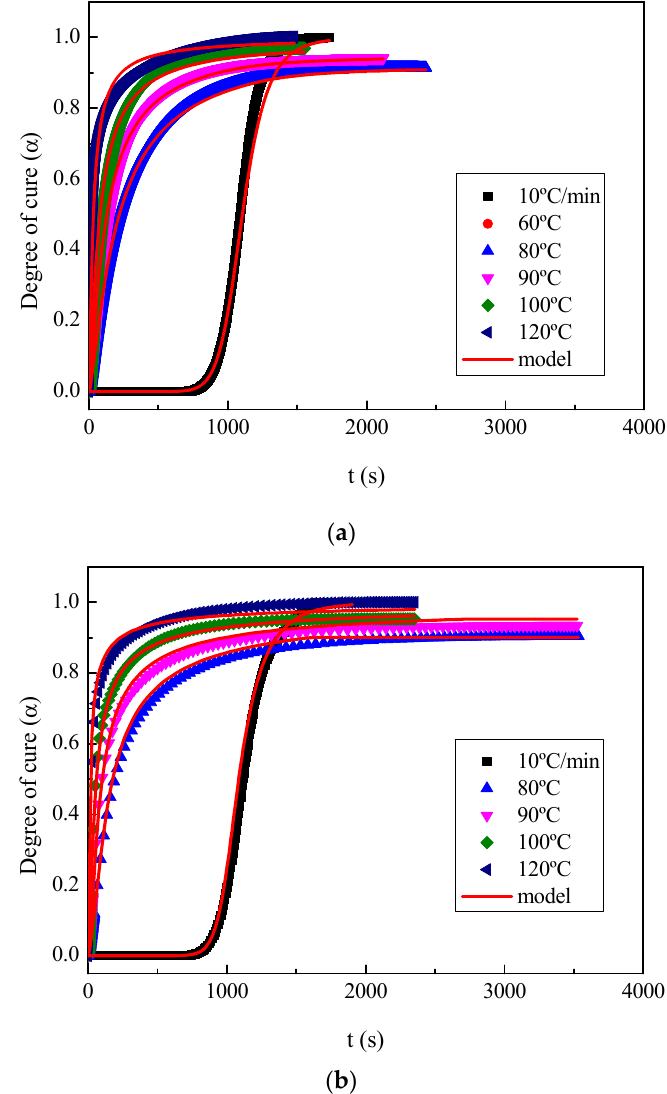
Figure 6. Degree of cure curves from DSC isothermal and dynamic tests (symbols) and model fitting (red lines) for ( a ) BIO-PUR2 and ( b ) BIOPUR3.